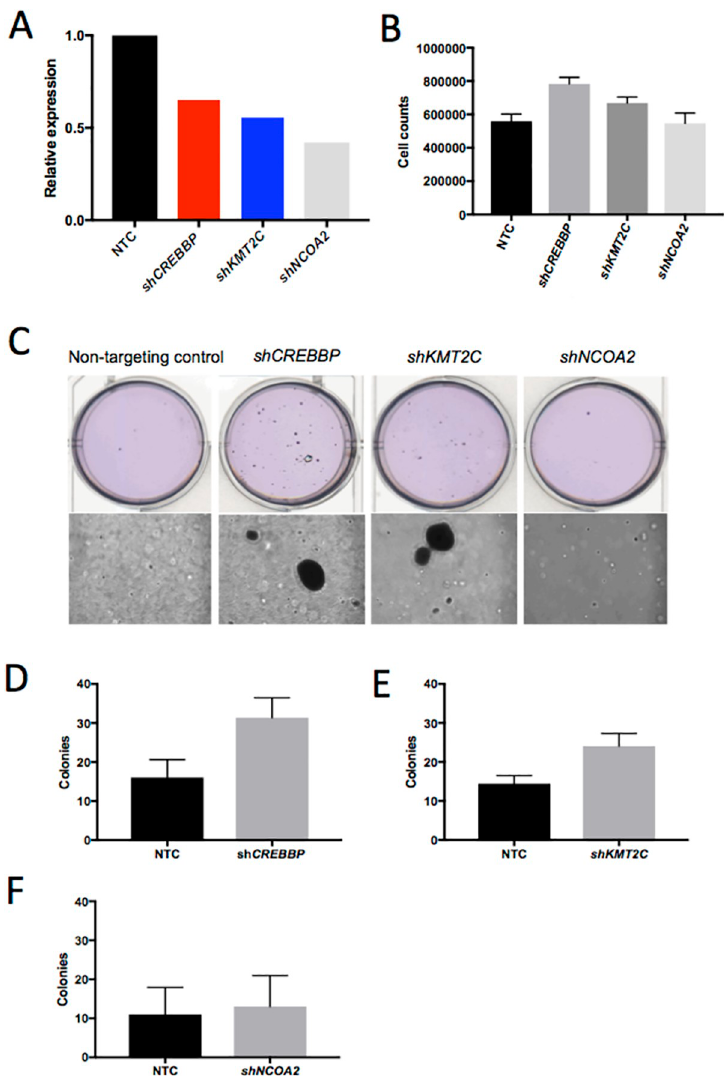
Fig 8. In vitro functional validation of chromatin remodelers in immortalized keratinocytes. Assessment of keratinocyte transformation in response to stable shRNA-mediated knockdown of CREBBP , KMT2C and NCOA2 in HaCaT cells ( A ) confirmed by Taq-Man showed cellular proliferation changes ( B ) with CREBBP knockdown relative to HaCaT cells stably transduced with a non-targeting shRNA (shNTC). Statistical significance was tested by one-way ANOVA ( P = 0.0024) followed by Sidak’s multiple comparisons adjustment (shNTC vs. shCREBBP , P = 0.0022; shNTC vs. shKMT2C , P = 0.19; shNTC vs. shNCOA2 , P = 0.99; n = 6 per group). Colony formation assays in soft agar ( C ) showed significant differences in the number and size of colonies from HaCaT cells with target gene knockdown compared to the non-targeting control for ( D ) CREBBP knockdown vs. shNTC, P = 0.018; ( E ) KMT2C knockdown vs. shNTC, P = 0.039; ( F ) NCOA2 knockdown vs. shNTC, P = 0.31. Colonies were stained with crystal violet solution and quantitated; statistical significance was tested using an unpaired t-test; n = 3 per